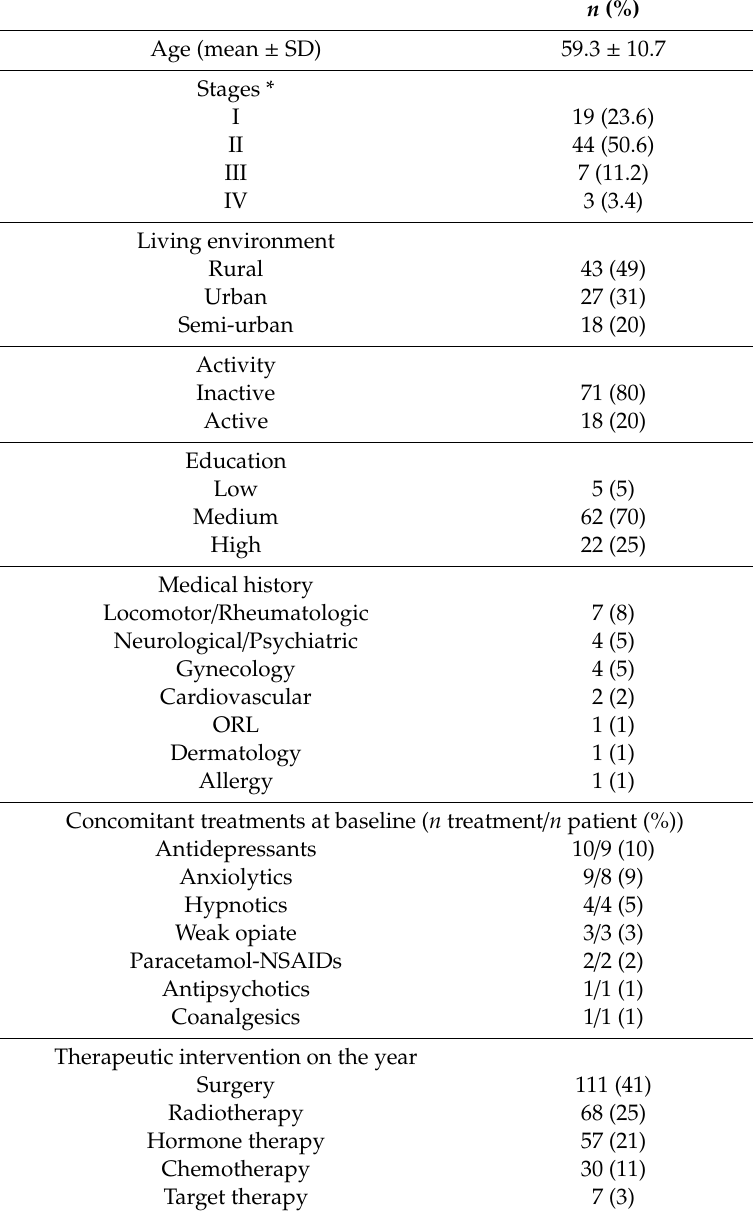
Table 1. Patient